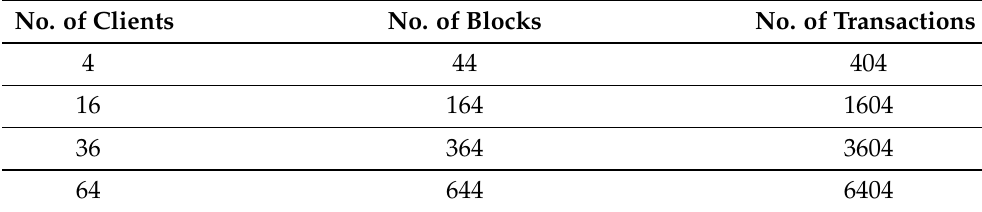
Table 7. Meter registration in the swarm network: multi-host-Raft orderer.